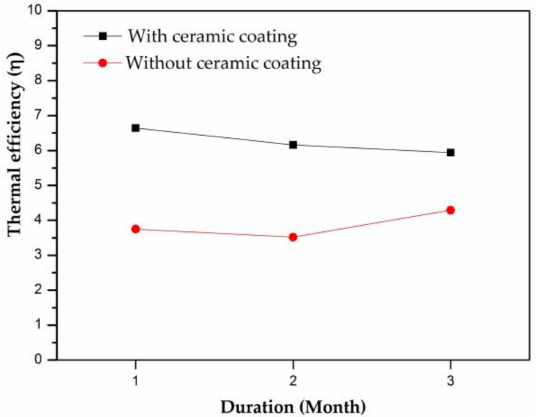
Figure 13. The thermal efficiency before and after applying the ceramic coating in boiler systems at JINJU INDUSTRY power plant in Chungcheongbuk-do (Korea).